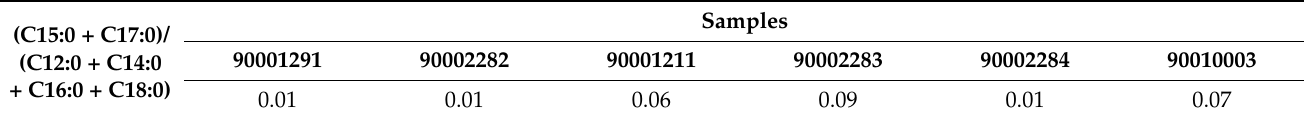
Table 3. Criteria used to distinguish the presence of ruminant animal fat based on fatty acid ratios of sum peak